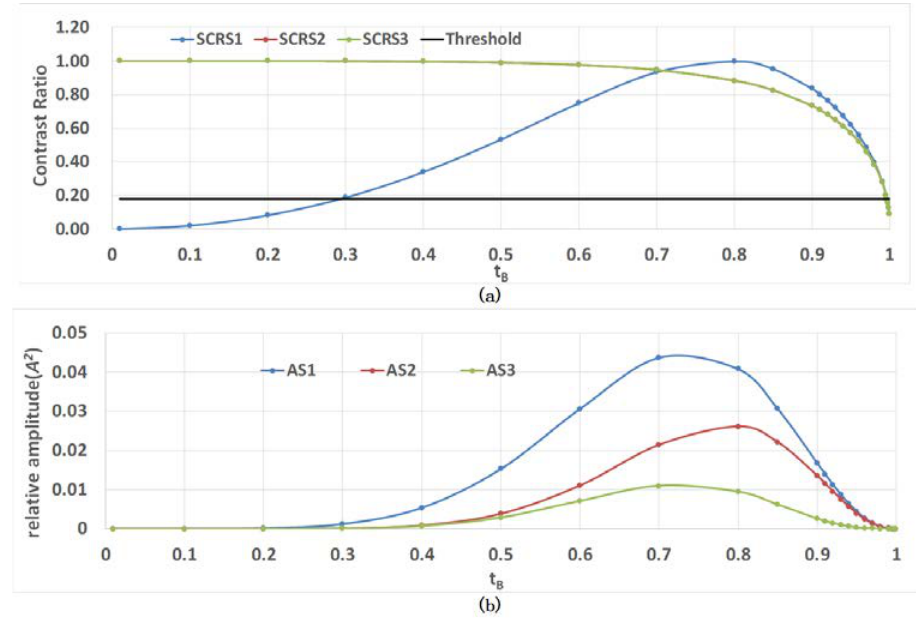
and and the amplitude transmission coefficients is the amplitude of the fringe. ( a ) Profile of SCR Sj 𝐴𝐴 𝑆𝑆𝑆𝑆 𝐴𝐴 𝑆𝑆𝑆𝑆